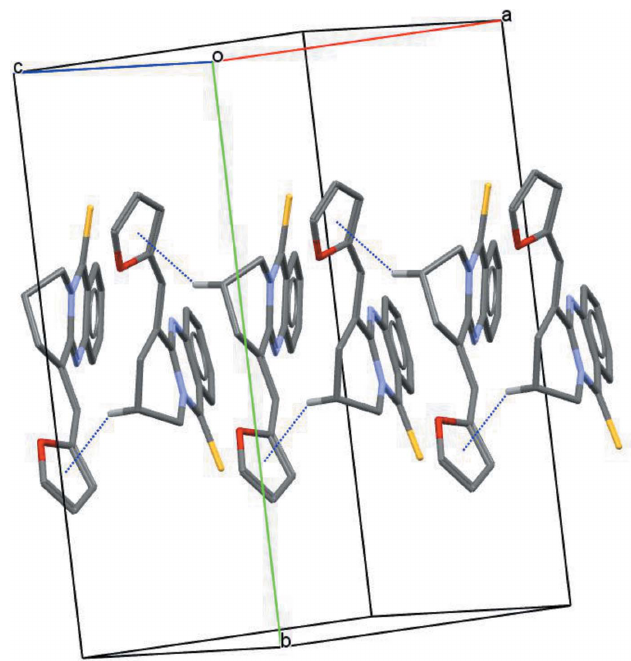
Figure 2 Chain of molecules of the title compound linked by C—H (cid:2)(cid:2)(cid:2) (cid:2) interactions. For clarity, H atoms not involved in these interactions have been omitted, and only atom H8 B has been included.